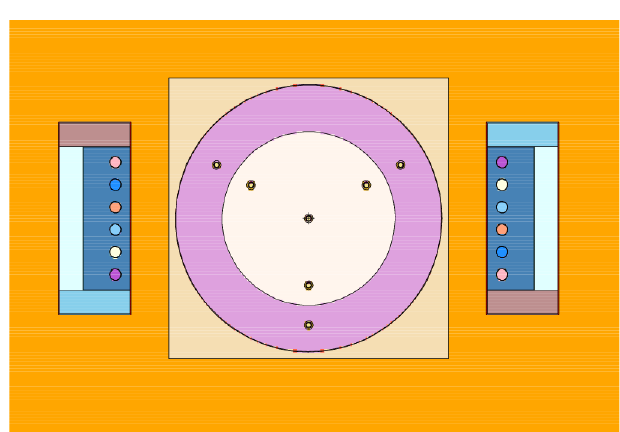
Figure 5: Horizontal cross section of the Monte Carlo model of the measurement setup for the 206 drum and the slab